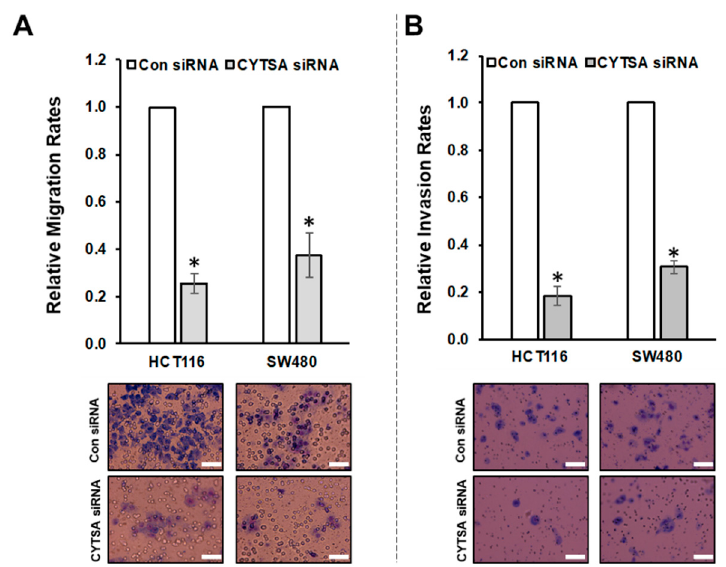
Figure 4. CYTSA regulates migration and invasion of CRC cells. ( A ) HCT116 and SW480 cells were transfected with Con siRNAs or CYTSA siRNAs, and migration of these cells were measured using Boyden chambers. Relative migration rates are plotted with migration rate for Con siRNA ‐ treated cells taken as 1.0. Representative images of the membranes are shown below. * p ‐ value < 0.05. ( B ) Relative invasion rates of HCT116 and SW480 cells transfected with Con siRNA or CYTSA siRNA are plotted. Representative images of the membranes from the invasion assays are shown below. * p ‐ value < 0.05. Scale bar = 50 μ m.